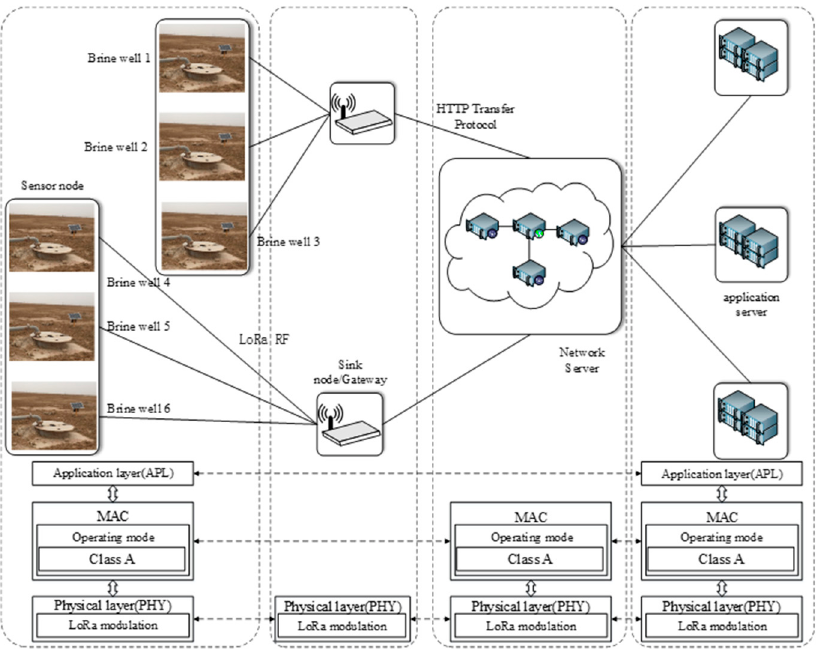
Figure 1. Wireless sensor network architecture based on LoRa.